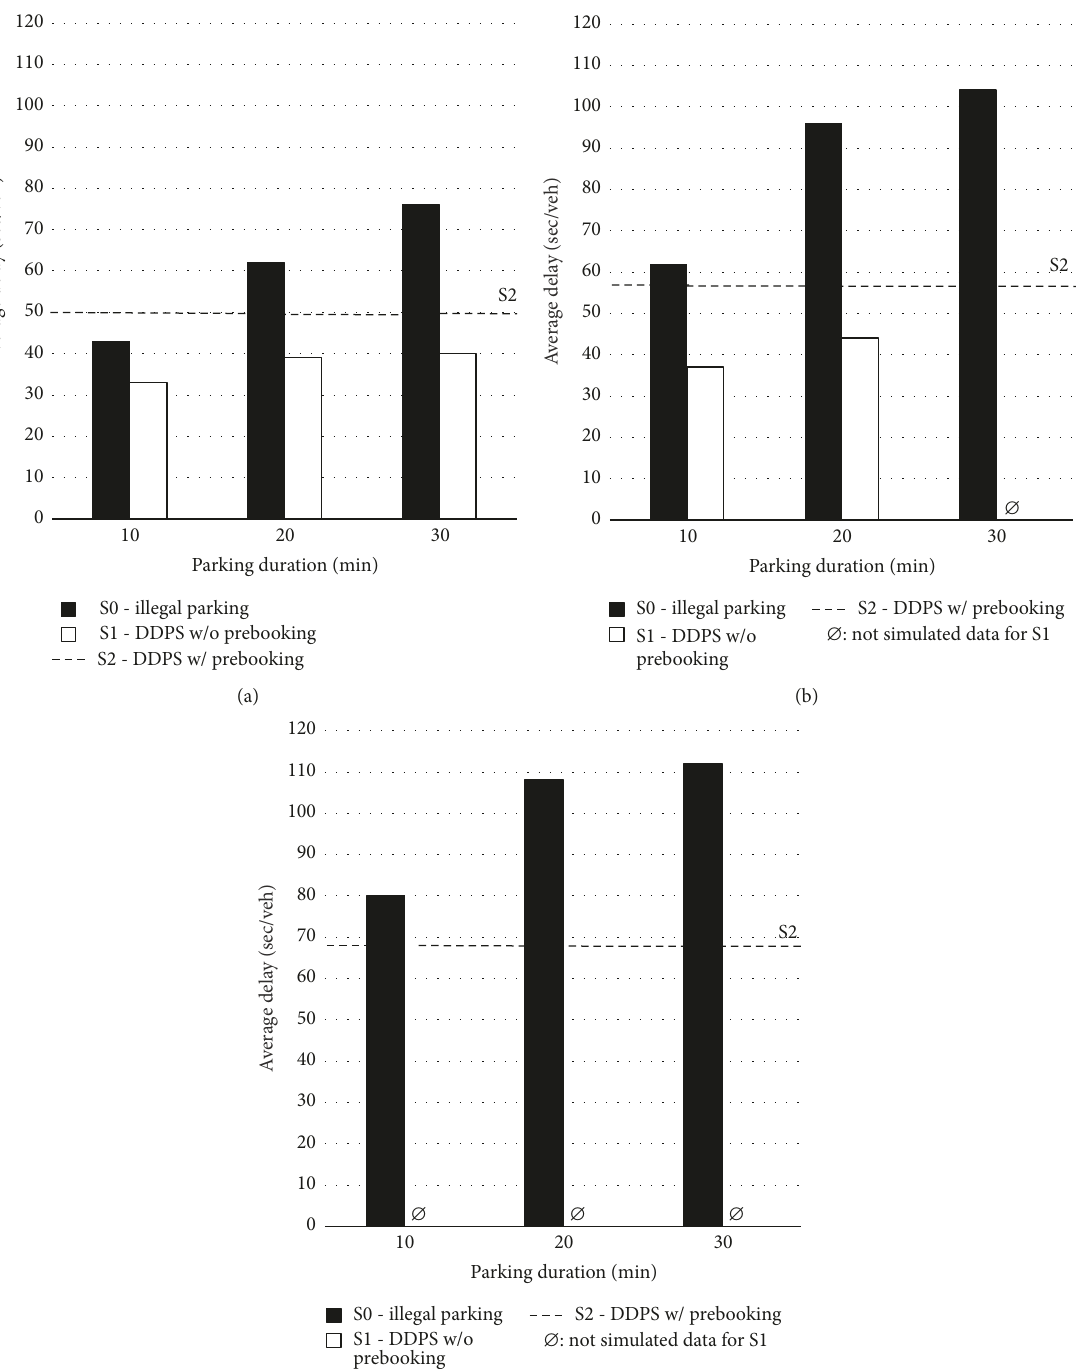
Figure 9: Average delay (sec/veh) in scenarios S0, S1, and S2 in case of traffic demand: (a) 988 veh/h; (b) 1090veh/h; (c)